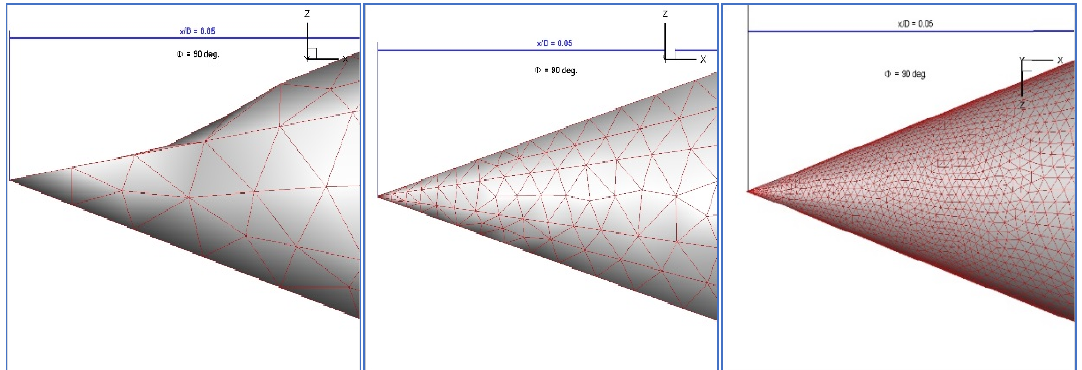
Figure 2. Detail of the unstructured grid at x/D < 0.05 and at orientation angle Φ = 90 deg. Left: mesh generated with m = 3. Center: Mesh generated with m = 8. Right: finer mesh generated with m = 8.